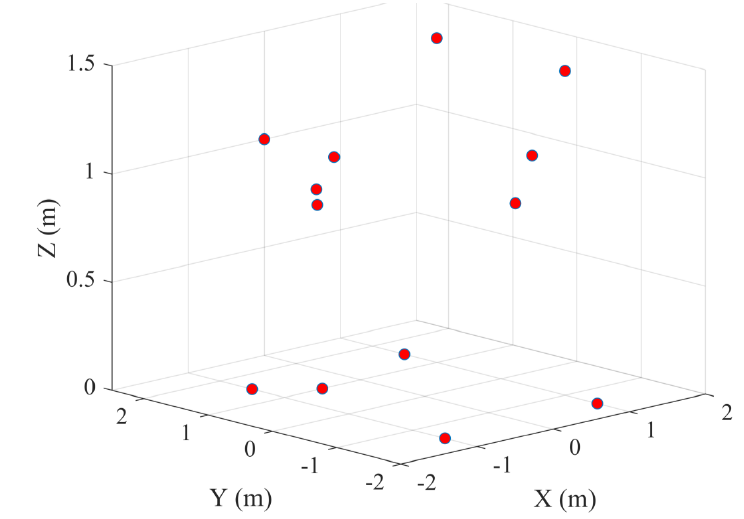
Figure 8. Point-scattering model simulation of space debris.